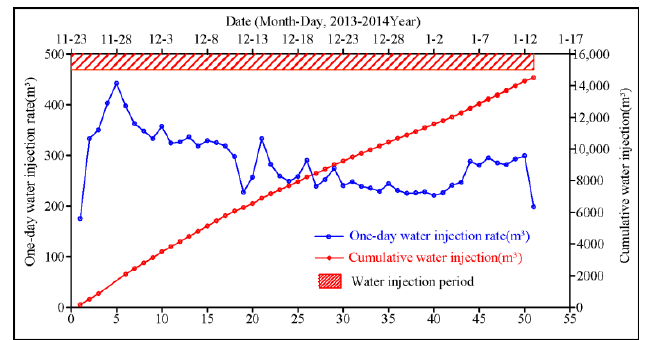
Figure 7. Water injection rate of the test.